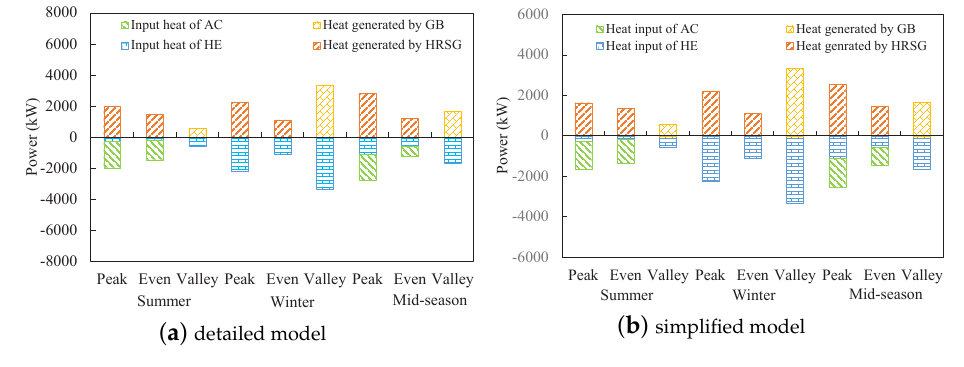
Figure 11. Heating optimization results as for Case 2.